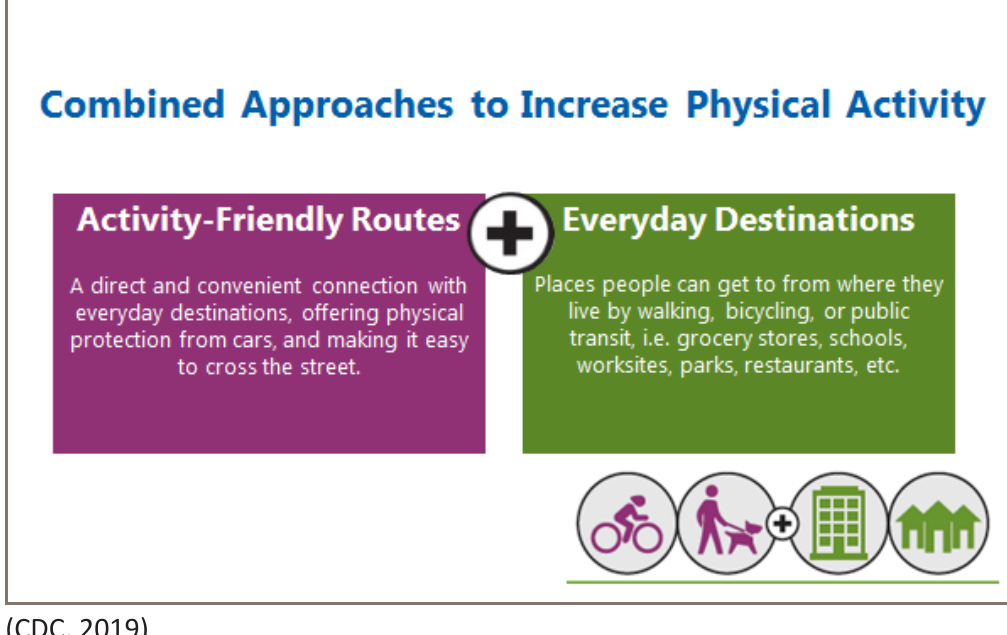
Figure 6: CDC Recommendation for Combined Built Environment Approaches to Increase Physical